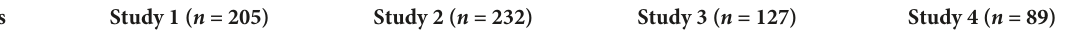
TABLE 6 Correlation coefficients among